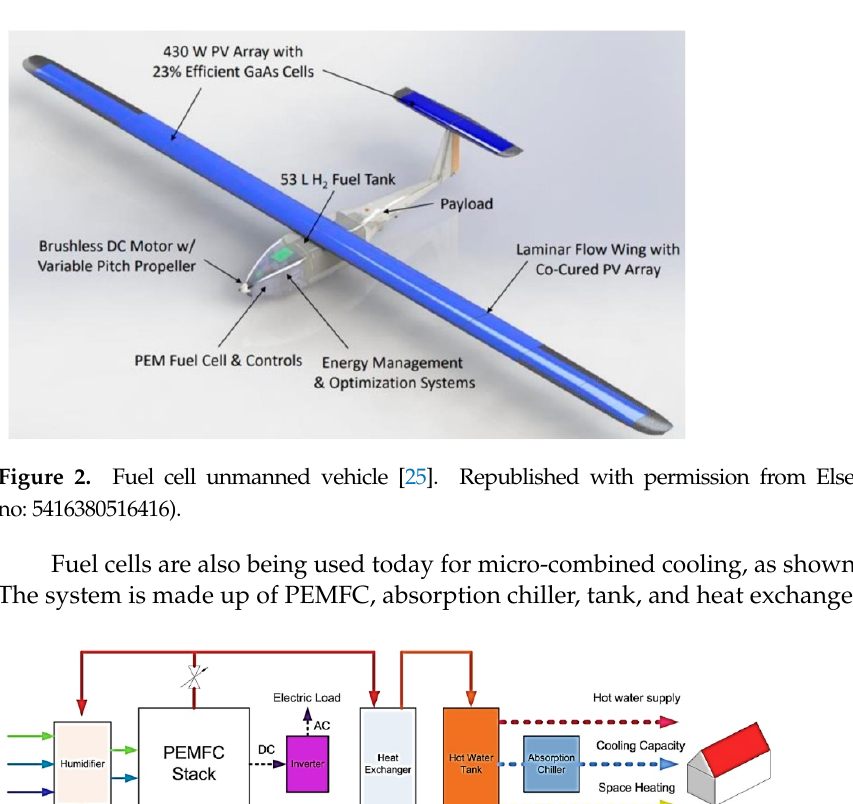
Figure 1. Fuel cell combined heat and power systems [24] (Published under open access).